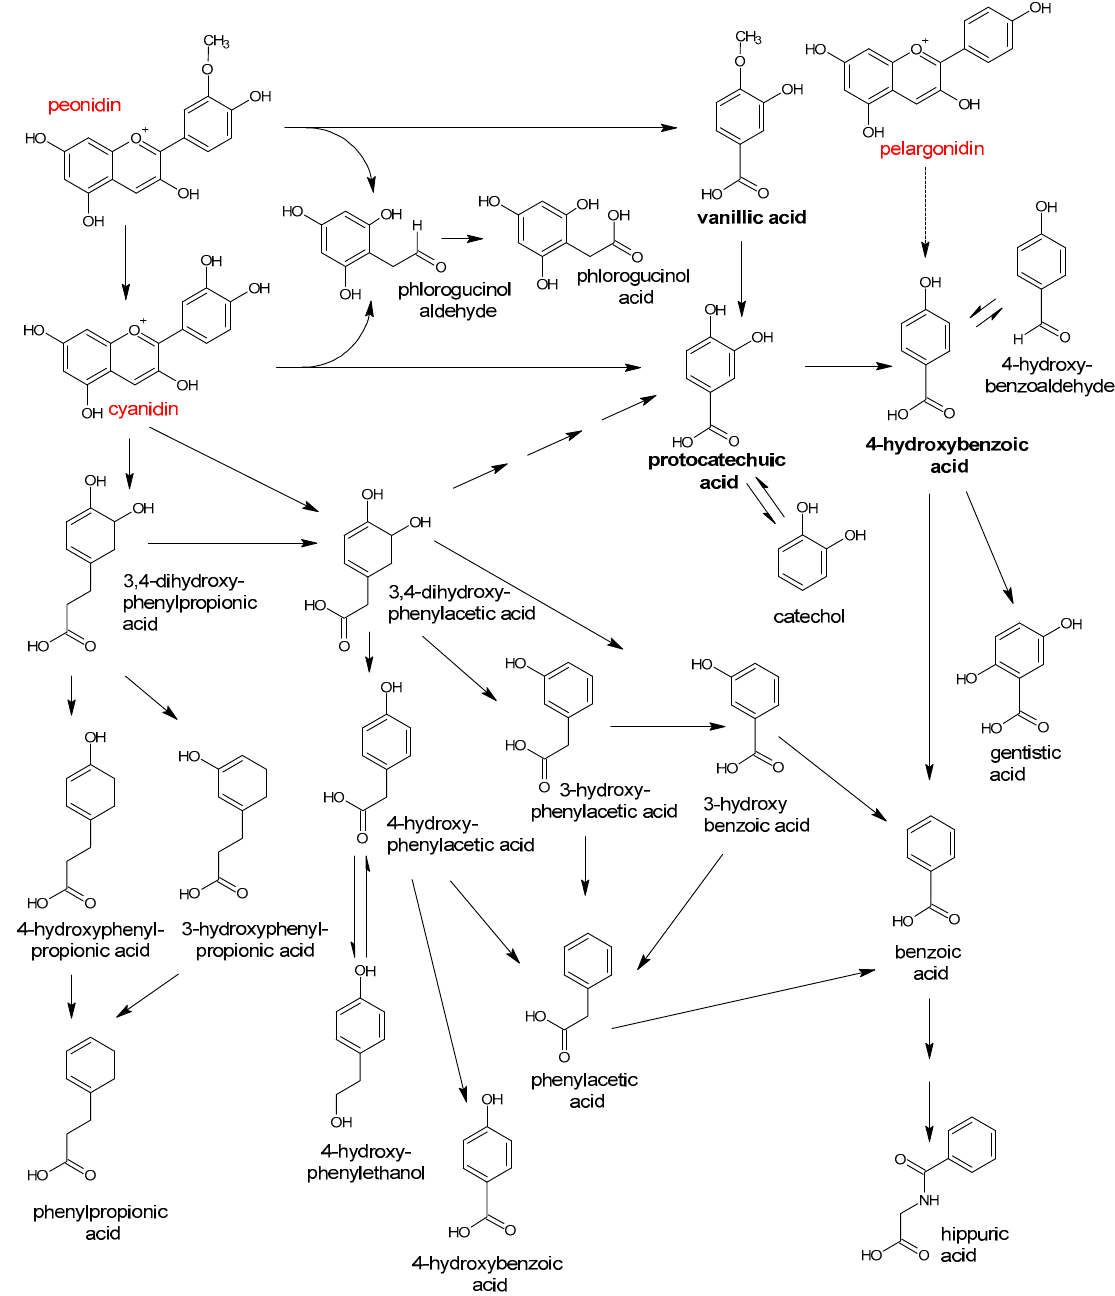
Figure 14. Biodegradation of anthocyanins and their main metabolites: cyanidin → 3,4-dihydroxybenzoic acid (protocate- chuic acid), peonidin → 3-methoxy-4-hydroxybenzoic acid (vanillic acid) and pelargonidin → 4-hydroxybenzoic acid. Based on [282,284,287,288].